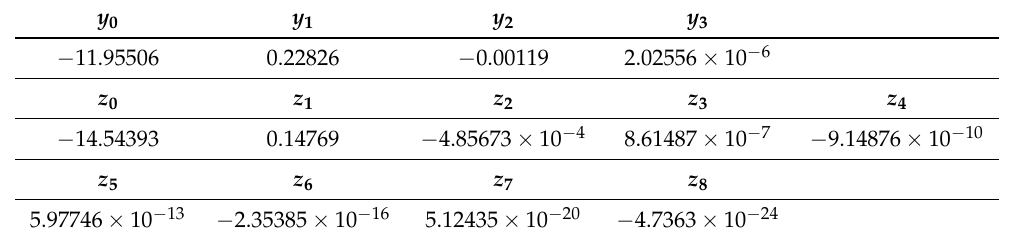
Table 8. The coefficient values for polynomial fitting of T h _ nw